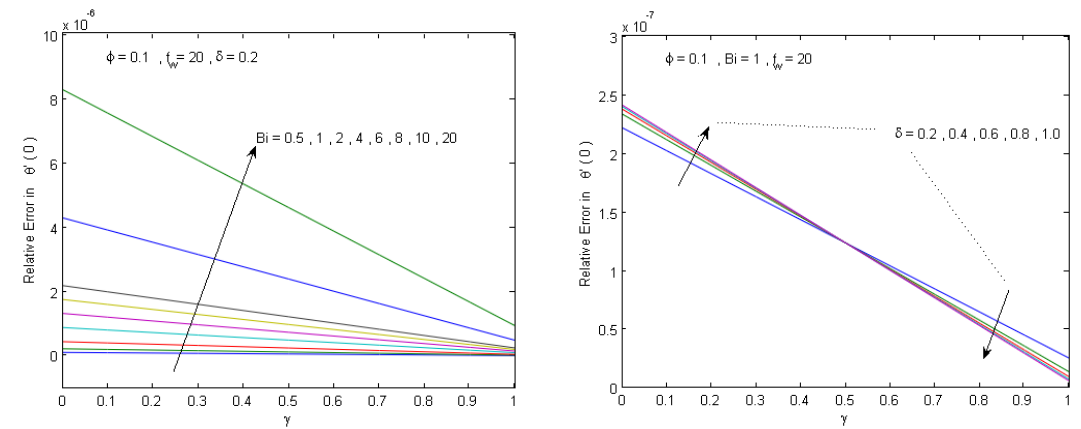
Figure 4. The effect of the physical parameters f w , φ , Bi , and δ on the maximum absolute error of the obtained analytical solution θ (0)